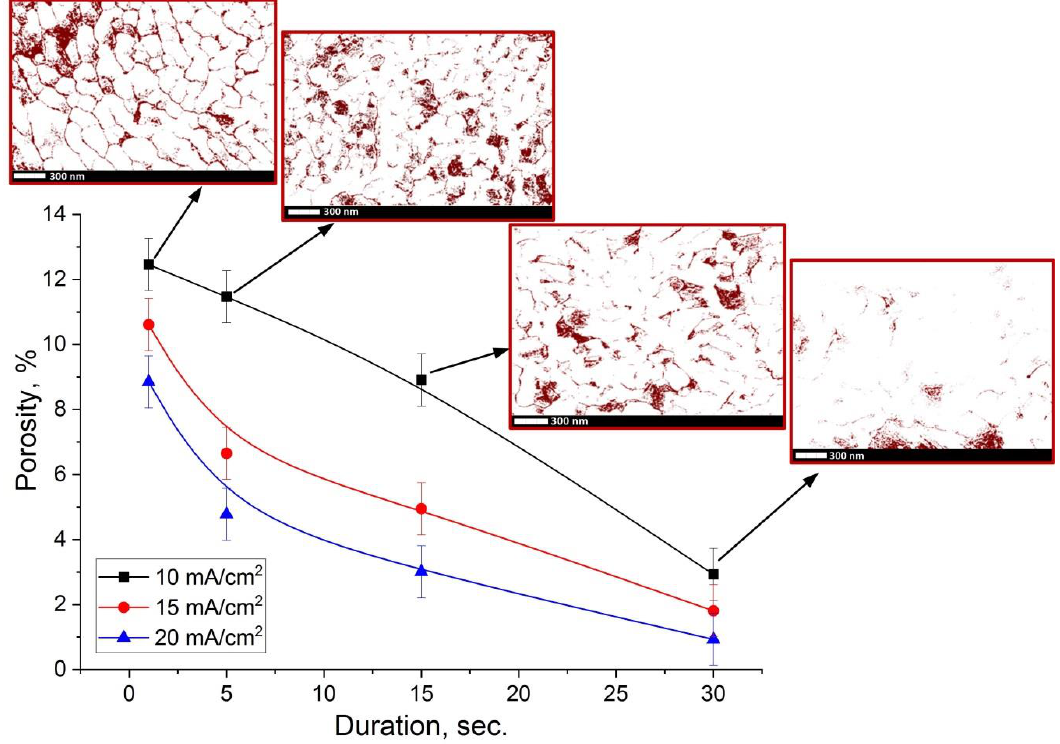
Figure 6. The dependence of films porosity on electrodeposition duration in PE at 10–20 mA/cm 2 current density. The inserts show the porosity contrast images for series 3 samples ( D c = 10 mA/cm 2 ).